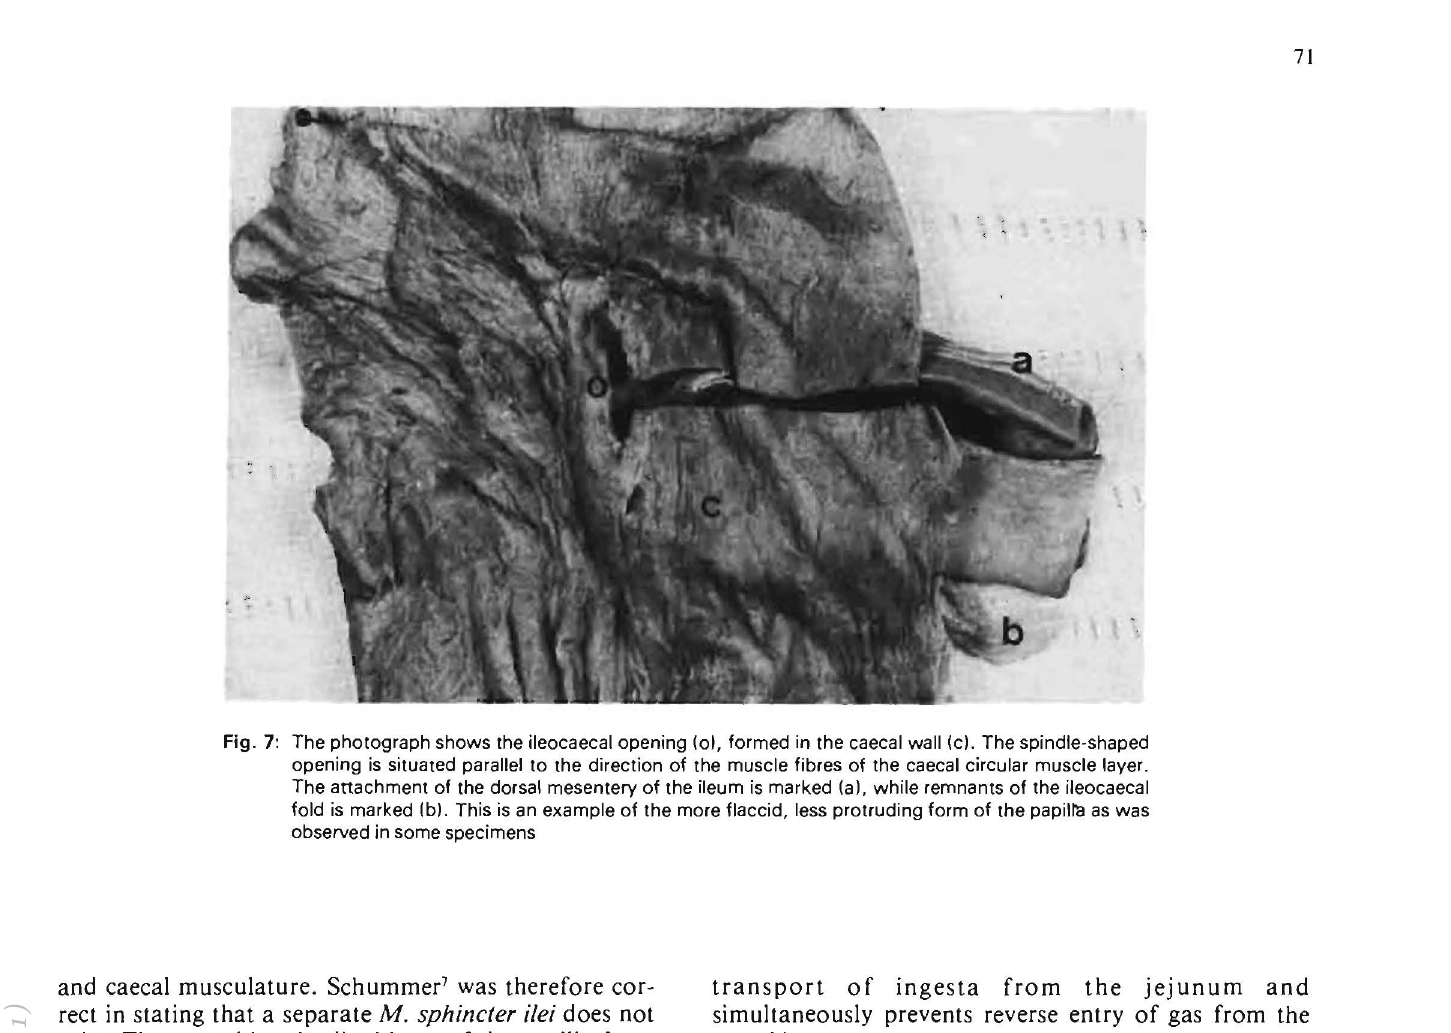
Fig. 7: The photograph shows the ileocaecal opening (01, formed in the caecal wall (c). The spindle-shaped opening is situated parallel to the direction of the muscle fibres of the caecal circular muscle layer. The attachment of the dorsal mesentery of the ileum is marked (ai, while remnants of the ileocaecal fold is marked (bl. This is an example of the more flaccid, less protruding form of the papilla as